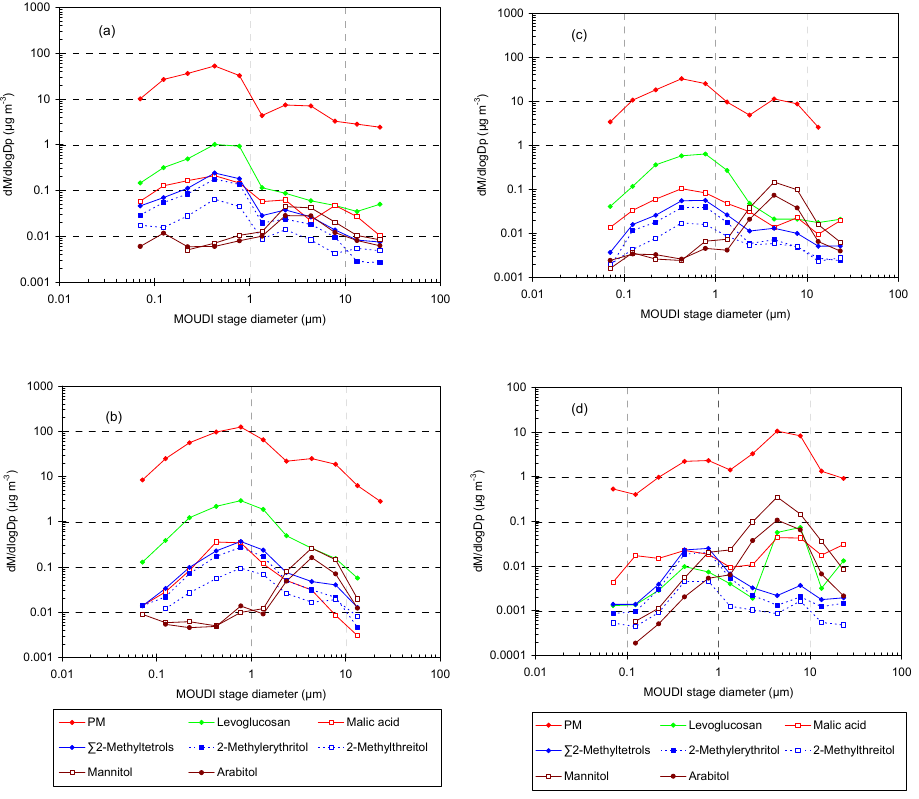
Fig. 4. Mass-size distributions of selected polar organic marker compounds and the PM during the 17 September 2002 day (a) and night (b) of the dry period, during a 24-h sampling on 17 October 2002 of the transition period (c), and during a 48-h sampling, 10-12 November 2002, of the wet period (d). Note that the ordinate scale covers 6 decades in all 4 figures, but that it starts 1 decade lower in figure (d) than in the other 3 figures..